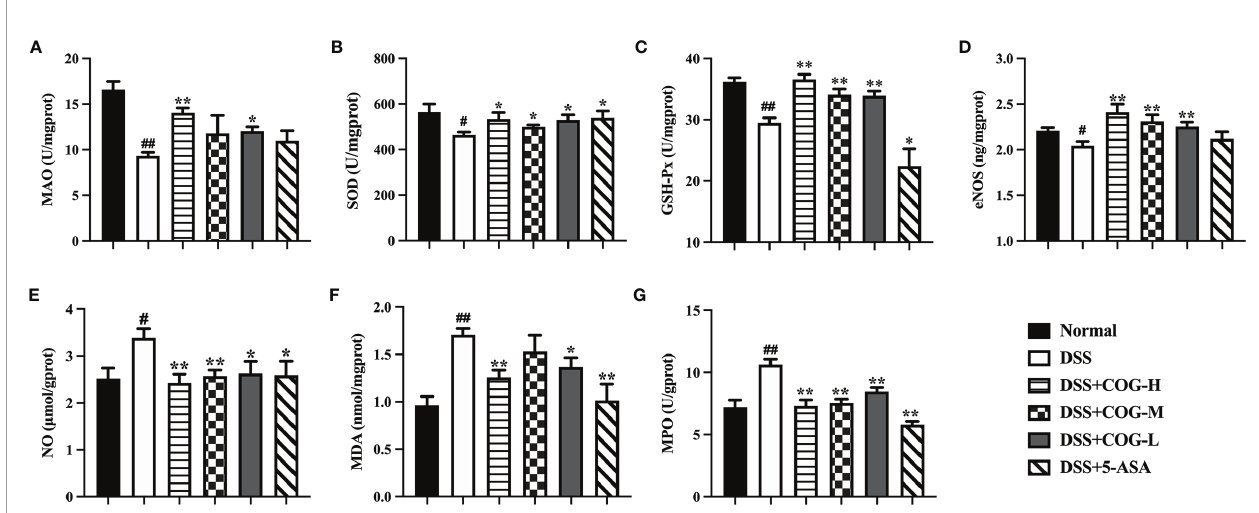
FIGURE 5 | Antioxidant activity of COG in colitic mice. (A) Monoamine oxidase (MAO) activity changes. (B) Superoxide dismutase (SOD) activity. (C) Glutathione peroxidase (GSH-Px) activity changes. (D) Endothelial nitric oxide synthase (eNOS) production. (E) Nitric oxide (NO) production. (F) Malondialdehyde (MDA) production. (G) Myeloperoxidase (MPO) activity changes. Data were presented as mean ± SEM ( n = 8 – 12). # p < 0.05 and ## p < 0.01 compared to the normal group; * p < 0.05 and ** p < 0.01 compared to the DSS